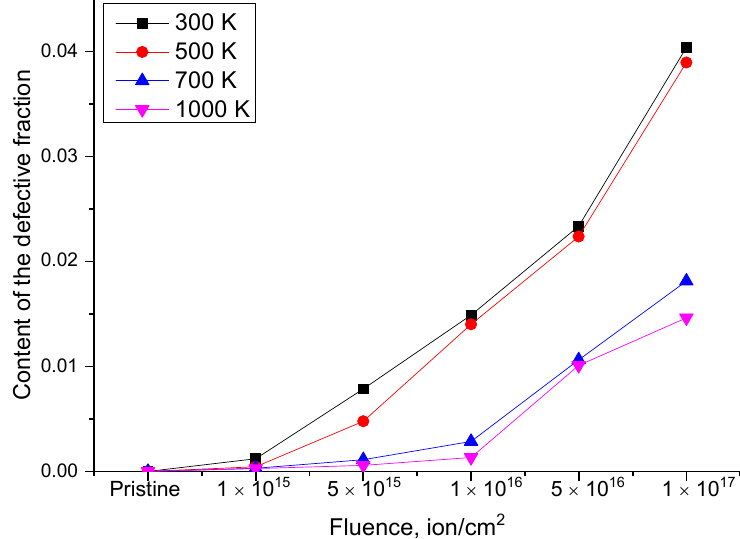
Figure 4. Results of changes in defective fraction depending on irradiation conditions.